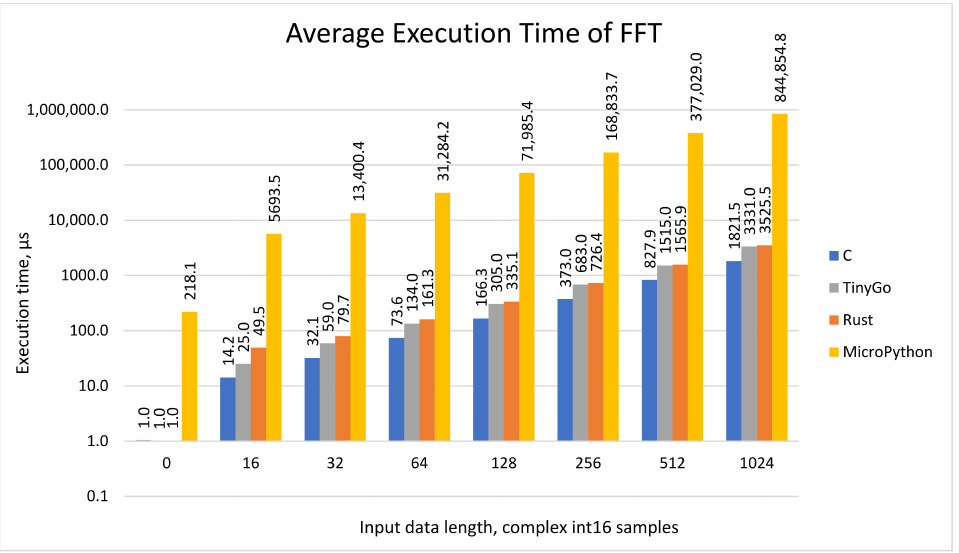
Figure 7. Average execution times of the FFT algorithm (please note the logarithmic time